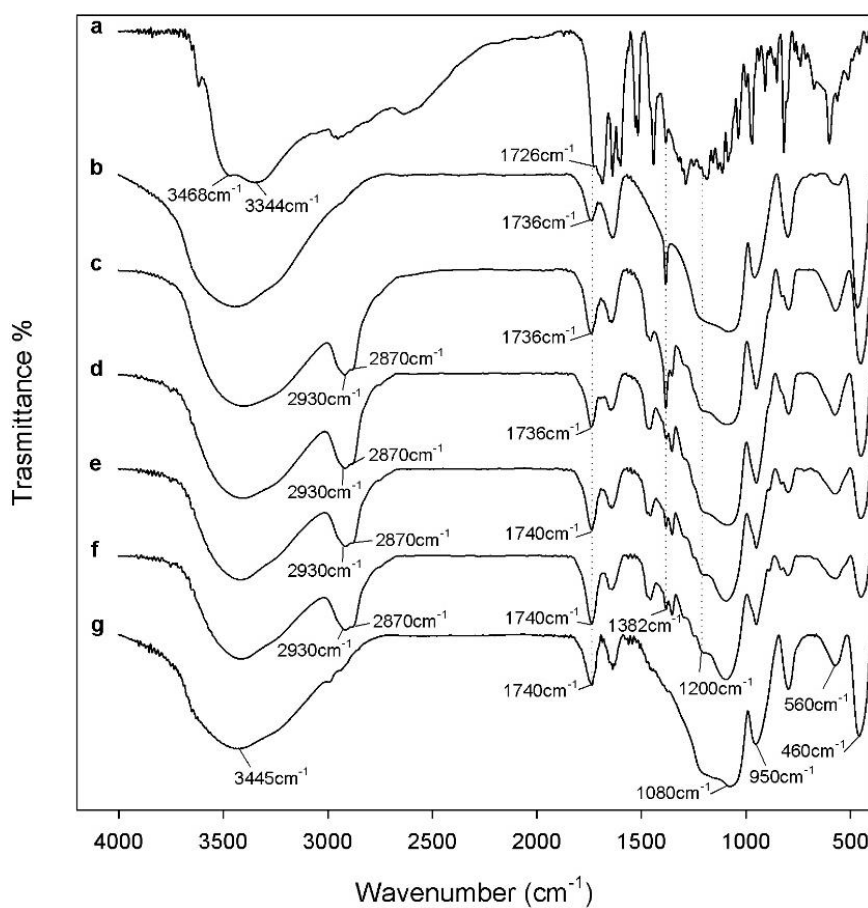
Figure 3. Representative FTIR spectra of: ( a ) pure CGA; ( b ) SiO 2 /CGA 5 wt % ; ( c ) SiO 2 /PEG 50 wt % /CGA 5 wt % ; ( d ) SiO 2 /PEG 50 wt % /CGA 10 wt % ; ( e ) SiO 2 /PEG 50 wt % /CGA 15 wt % ; ( f ) SiO 2 /PEG 50 wt % /CGA 20 wt % ; ( g ) SiO 2 /CGA 20 wt % .